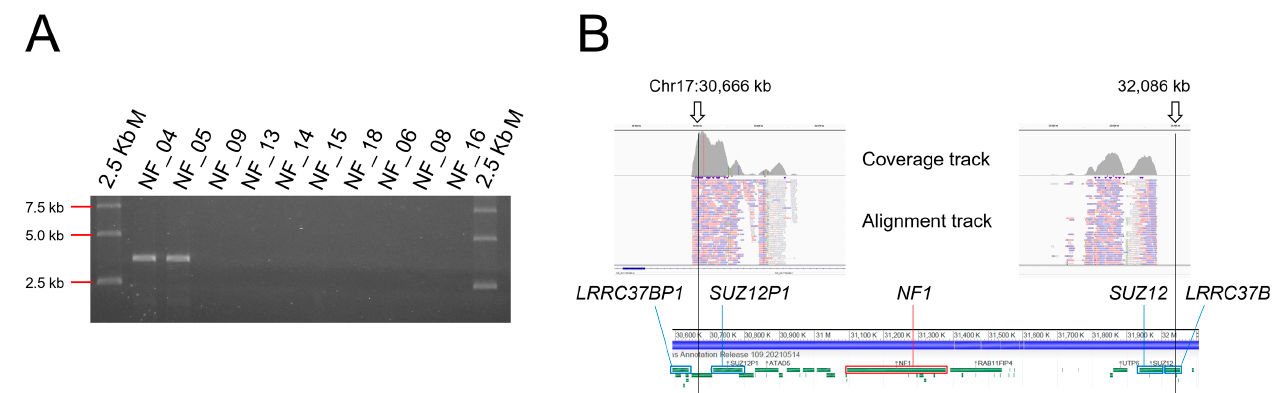
Figure 3. Detection of the type-1 microdeletion of NF1 . ( A ) The 0.5% agarose gel electrophoresis of type-1 microdeletion- specific long PCR. ( B ) NGS mapping of the PCR amplicon of NF_04. This PCR product was mapped separately at a distance of 1420 Kb containing NF1 (31,090 kb–31,380 kb) as the expected loci described in the text. On the alignment track, pink and purple colours indicate the direction of the read strands, and white indicates the reads mapped to multiple regions due to pseudogenes.